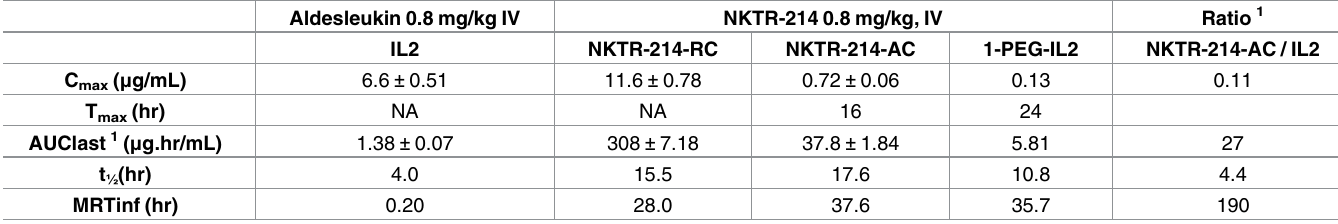
Table 2. Mean ( ± SE) plasma PK parameters after administration of NKTR-214or aldesleukin, each at 0.8 mg/kg,